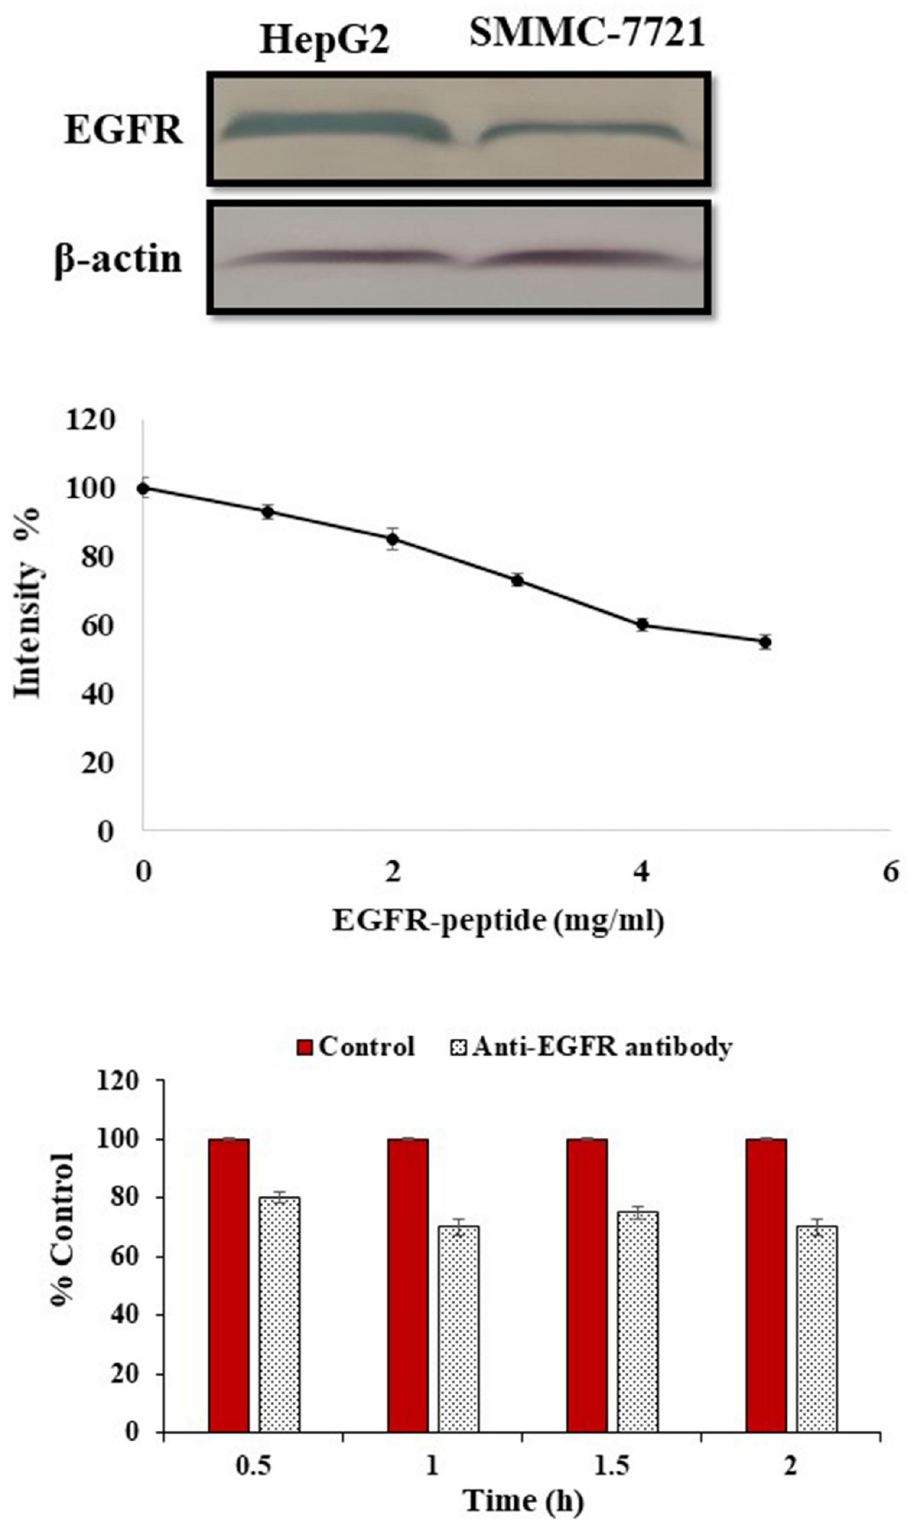
Fig 6. EGFR expression and selective cellular uptake of targeted bee venom-CSNPs. ( A ) EGFR expression; ( B ) selective cellular uptake of coumarin-6 loaded targeted bee venom-CSNPs; ( C ) and anti-EGFR antibody blocking in HepG2 and SMMC-7721